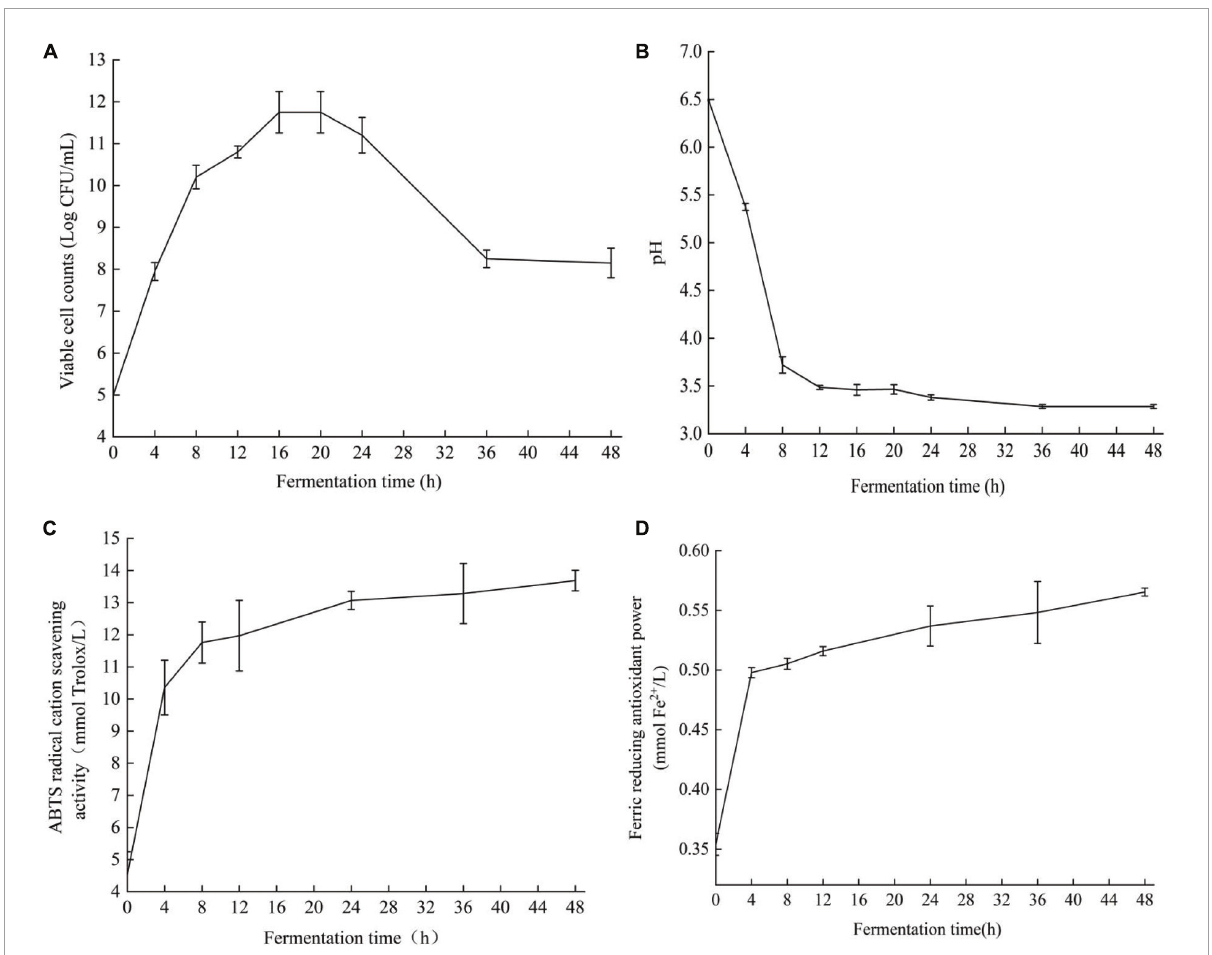
FIGURE2 Viable cell count (A) , changes of pH (B) , ABTS + free radical scavenging ability (C) , FRAP reducing antioxidant capacity (D) of Ginkgo biloba kernel juice fermented by strain